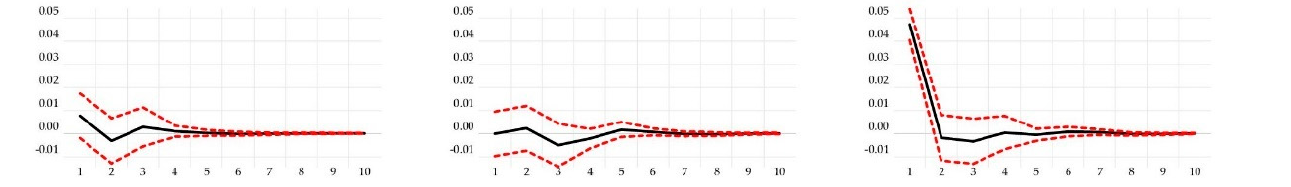
Figure A3. Response to Cholesky one std. dev. Innovations ±2 analytic asymptotic std. errors in model 3.